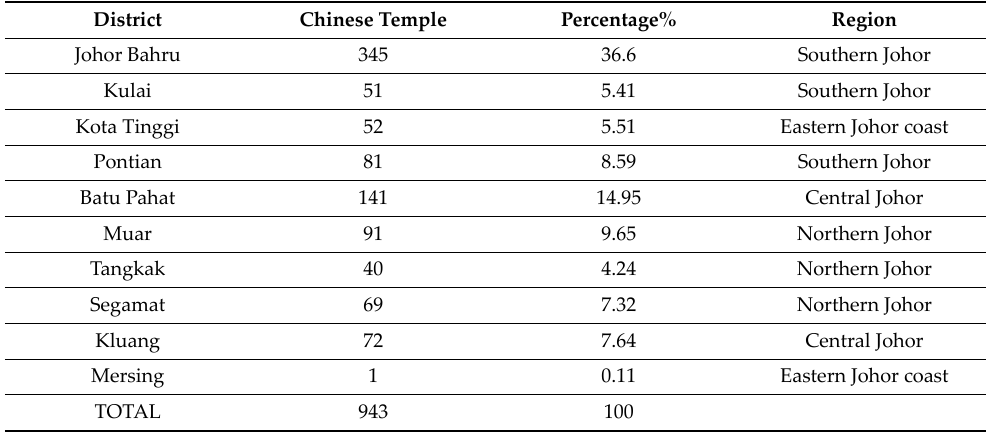
Table 6. Total Number of Temples in Each